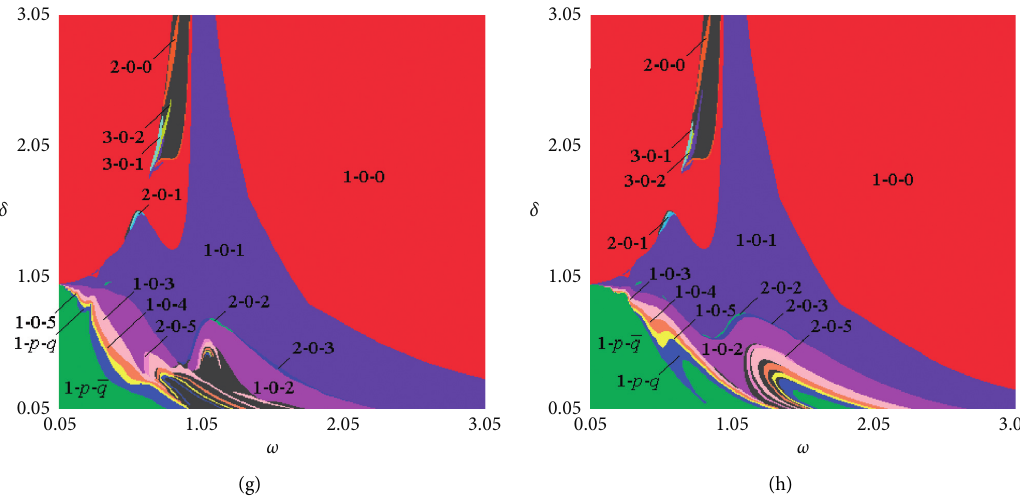
Figure 9: Under different damping ratios μ : μ � μ (b) M c c 0.25; (c) 1